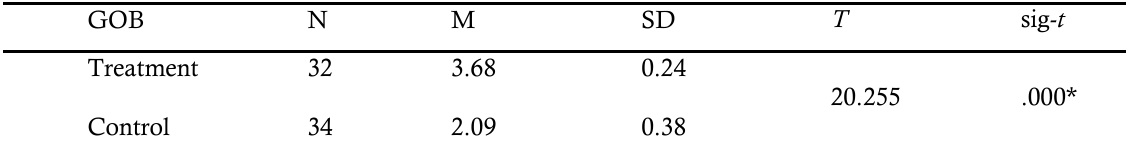
Table 5. Results of independent sample t-test between treatment group and control group on adolescent’s goal orientation behavior mean score for follow- up test GOB N M SD T sig- t Treatment 32 Control